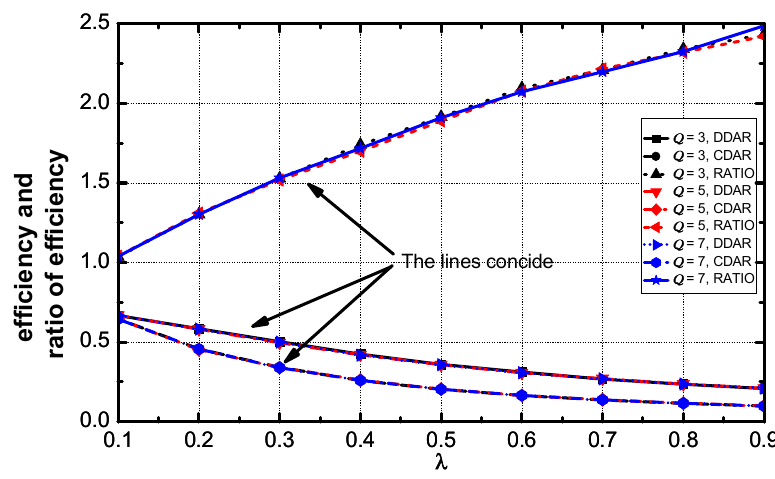
Figure 16. Average energy consumption and the ratio vs. λ .